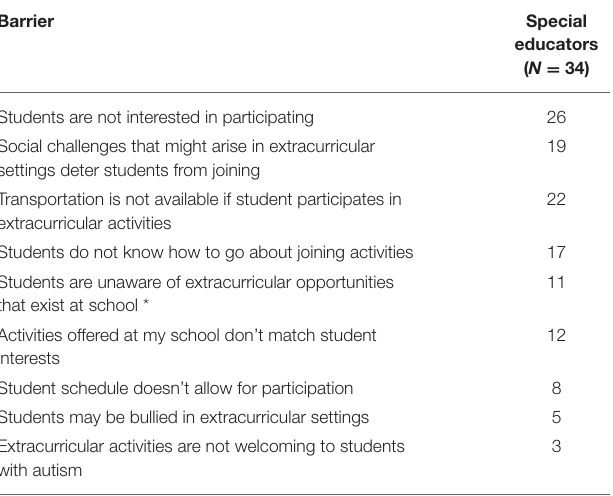
TABLE 3 | Perceived barriers to club participation.